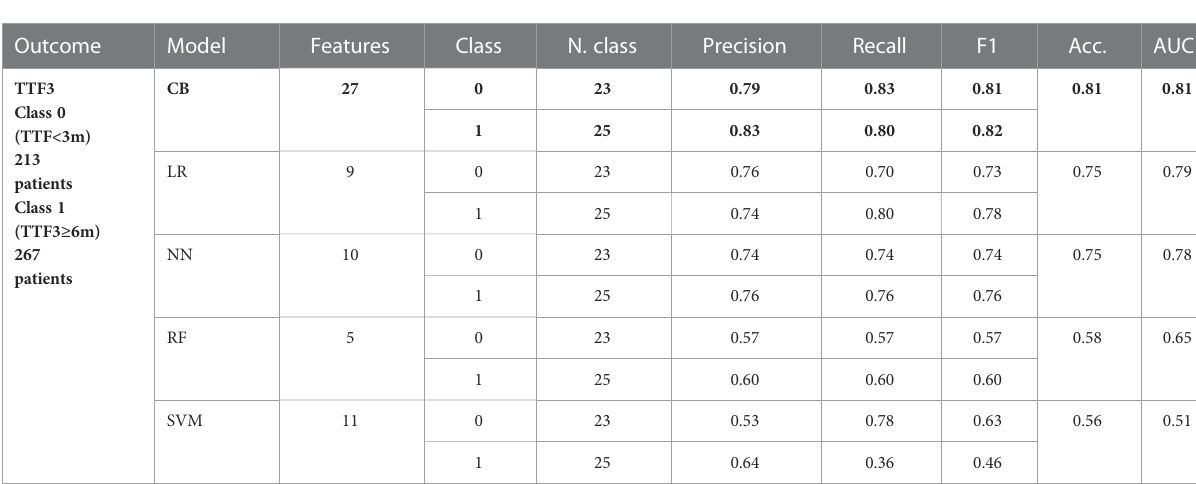
TABLE 5 Performance of classi fi cation models on the test dataset; outcome – TTF3.